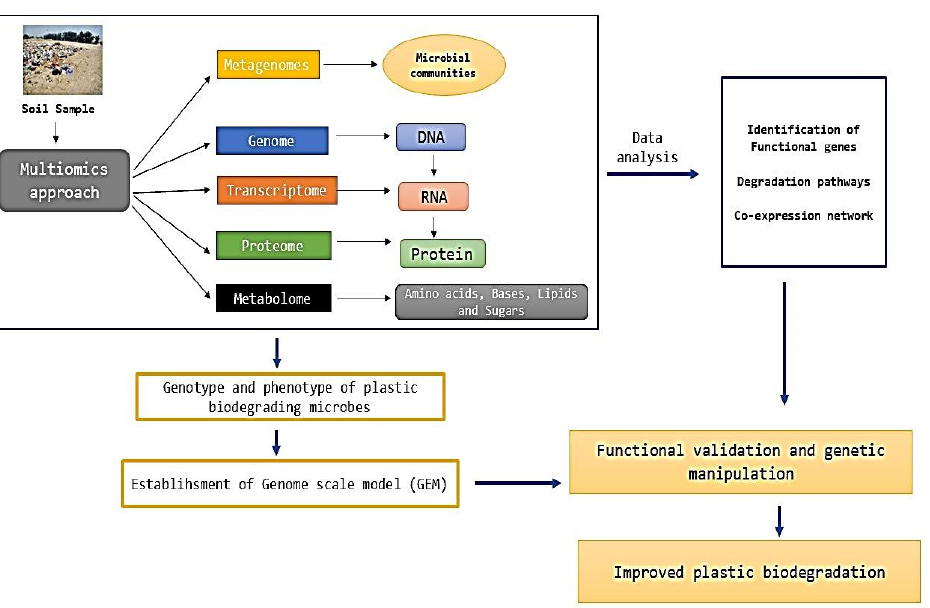
Figure 7. The multiomics approach for plastic degradation. Various approaches such as metagenomic, genomic, transcriptomic, proteomic, and metabolomic approaches are followed for the degradation of plastics. High ‐ throughput techniques can be followed to do so.